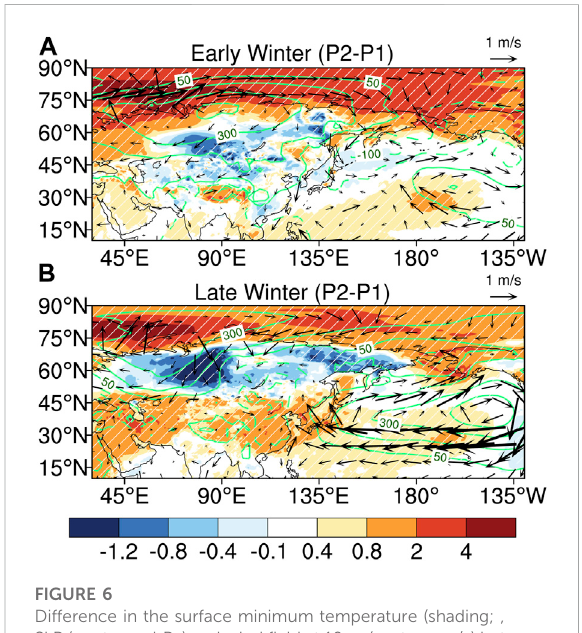
FIGURE 6 Difference in the surface minimum temperature (shading; , SLP (contours; hPa) and wind fi eld at 10 m (vectors; m/s) between P2 and P1 in (A) early winter and (B) late winter. The white slanted lines represent p < 0.05.